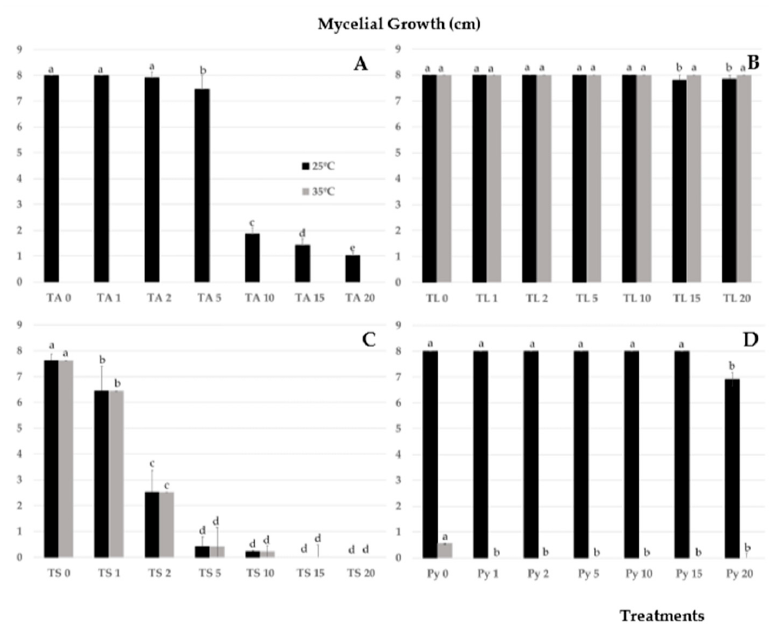
Figure 2. Mycelial growth (cm) of Trichoderma isolates as affected by different concentrations of NaCl (0–20 g·L − 1 ) and temperatures (25/35 °C). ( A ) Trichoderma aggressivum f. sp. europaeum. ( B ) T. longibrachiatum. ( C ) T. saturnisporum. ( D ) Pythium ultimum. Mean standard deviation is expressed in